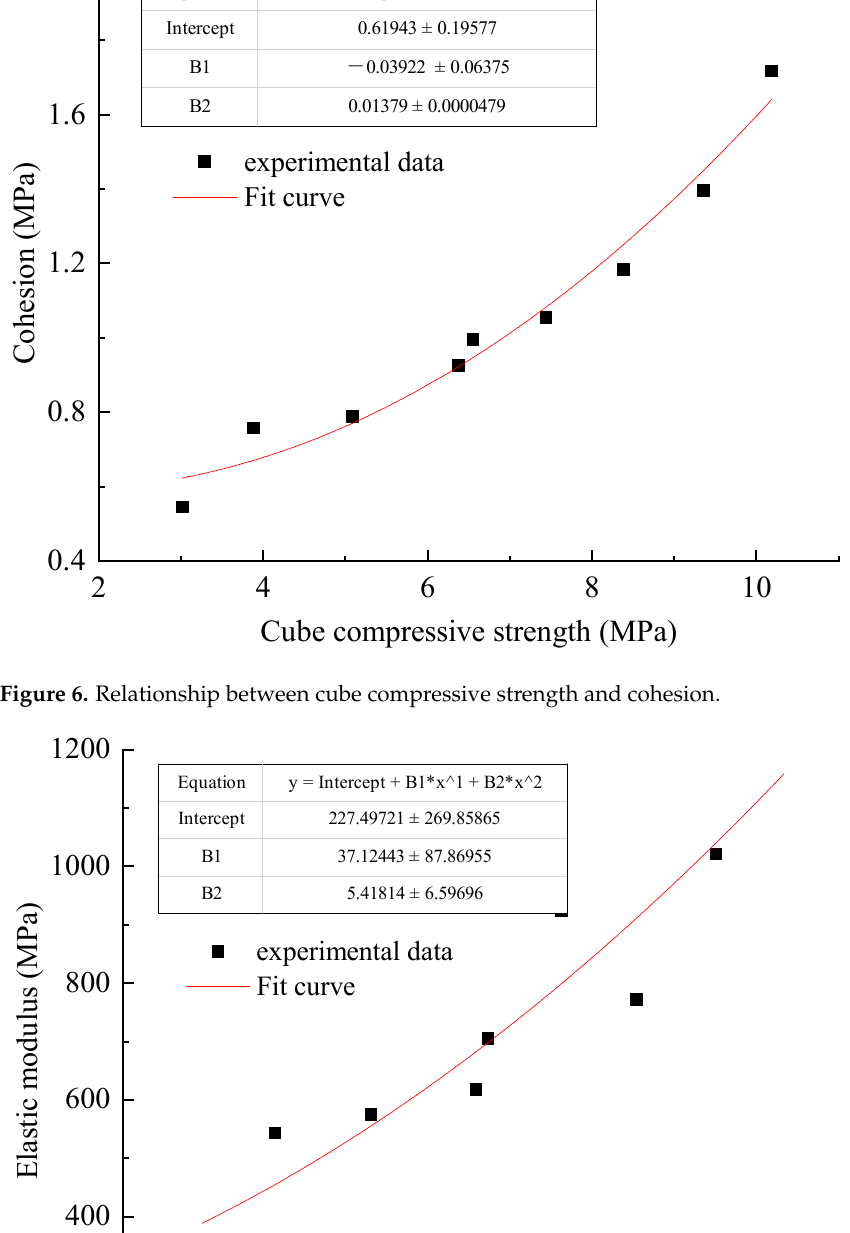
Figure 6. Relationship between cube compressive strength and cohesion.